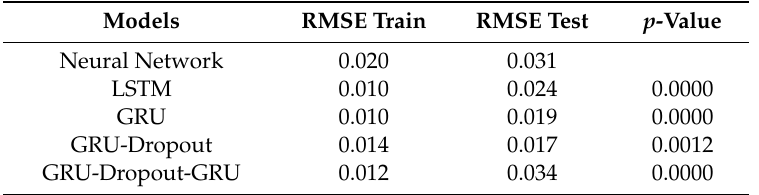
Table 2. Train test root mean squared error (RMSE) of 30 days lookback period for di ff erent